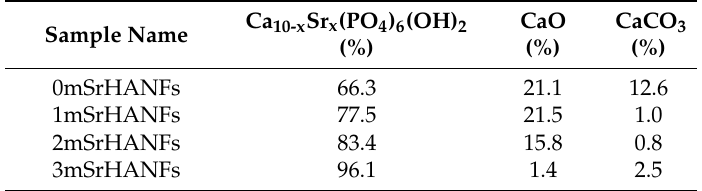
Table 4. Phase composition of samples determined by DIFFRAC.EVA analysis of X-ray diffraction (XRD) patterns.